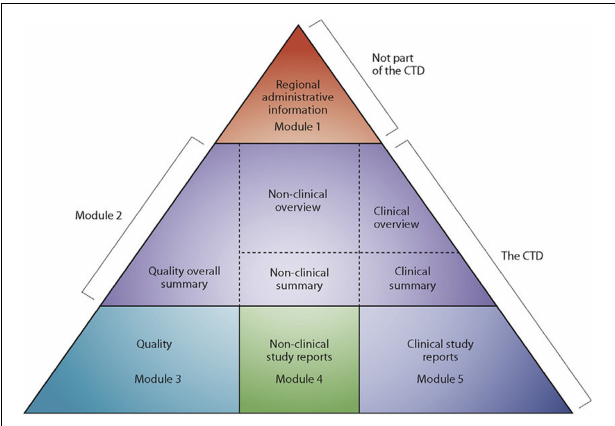
FIGURE 1 | The Common technical document triangle